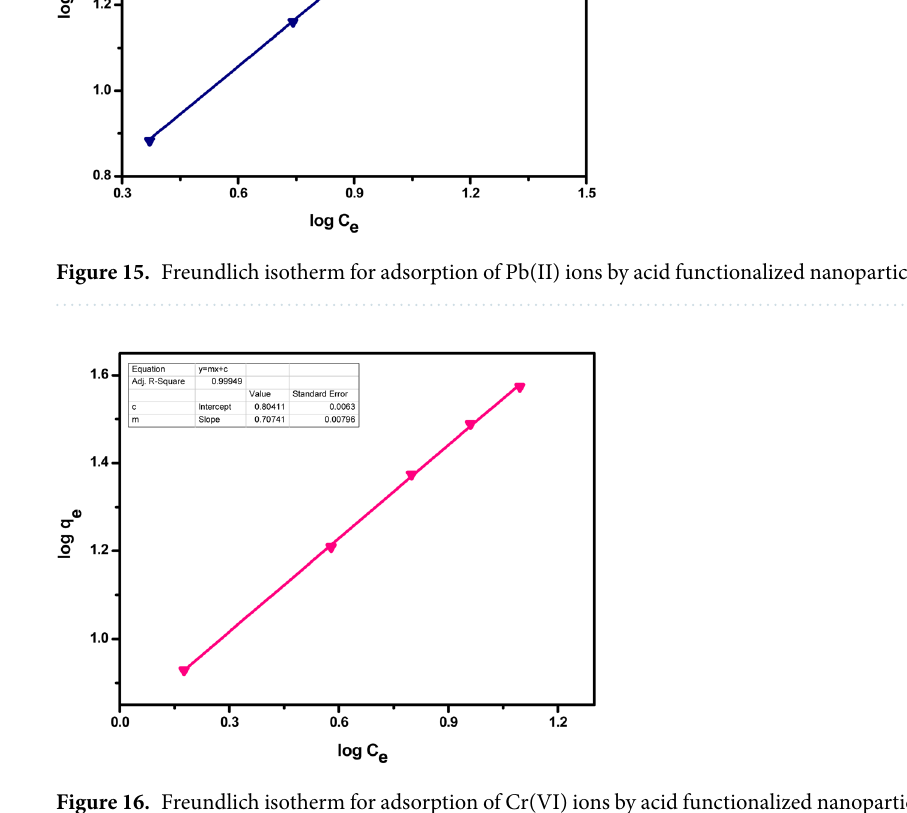
Figure 16. Freundlich isotherm for adsorption of Cr(VI) ions by acid functionalized nanoparticles.